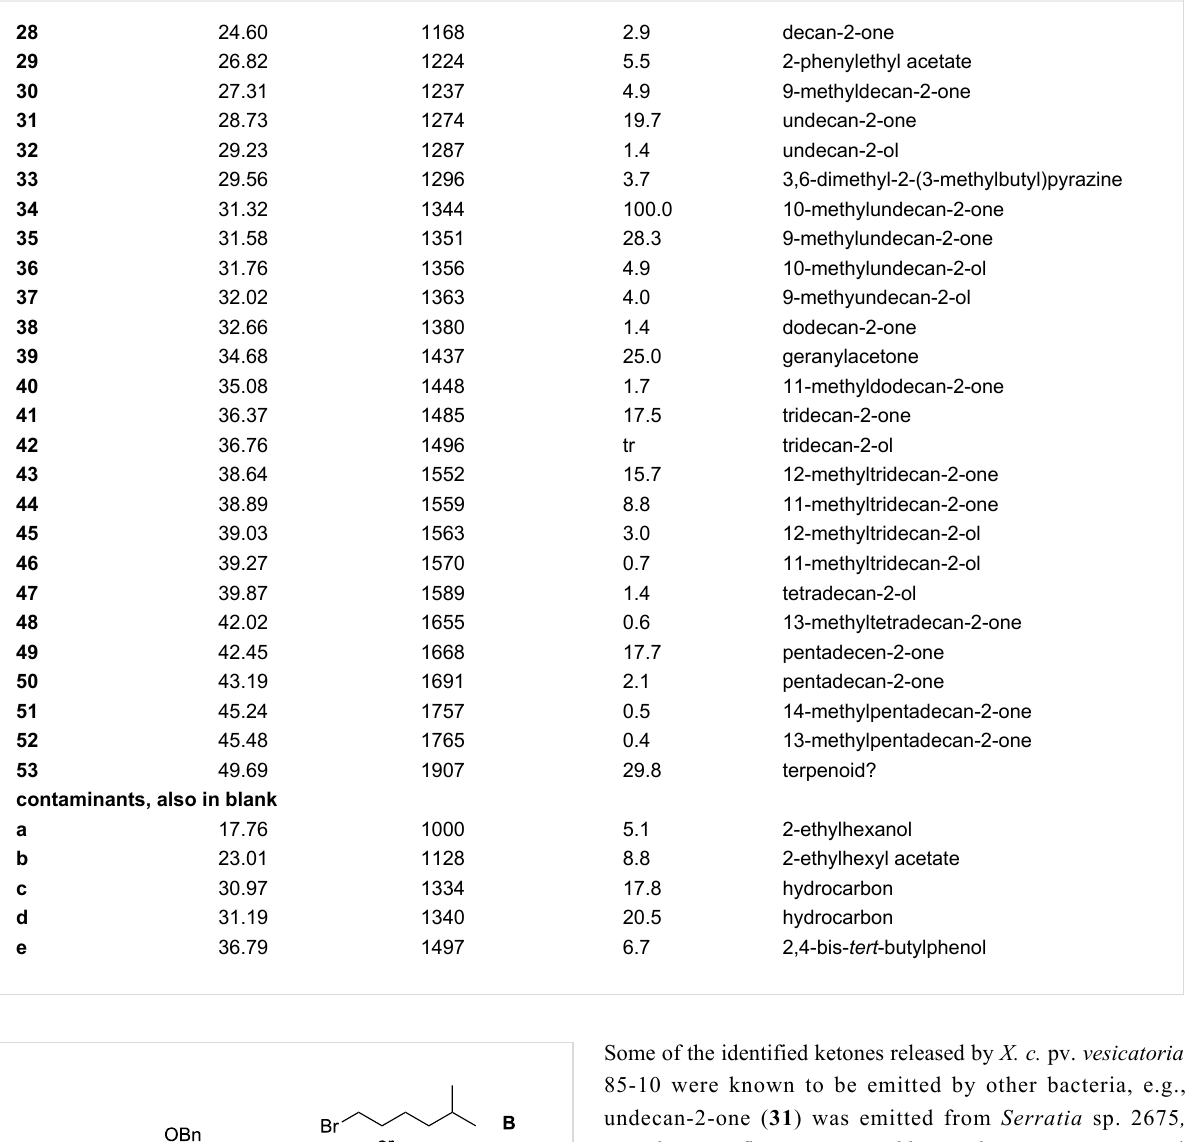
Table 1: GC/MS analysis of Super-Q trapped volatiles emitted by Xanthomonas campestris pv. vesicatoria 85-10 grown in 10 L nutrient broth without glucose. Compound labels are the same throughout this paper. (continued)